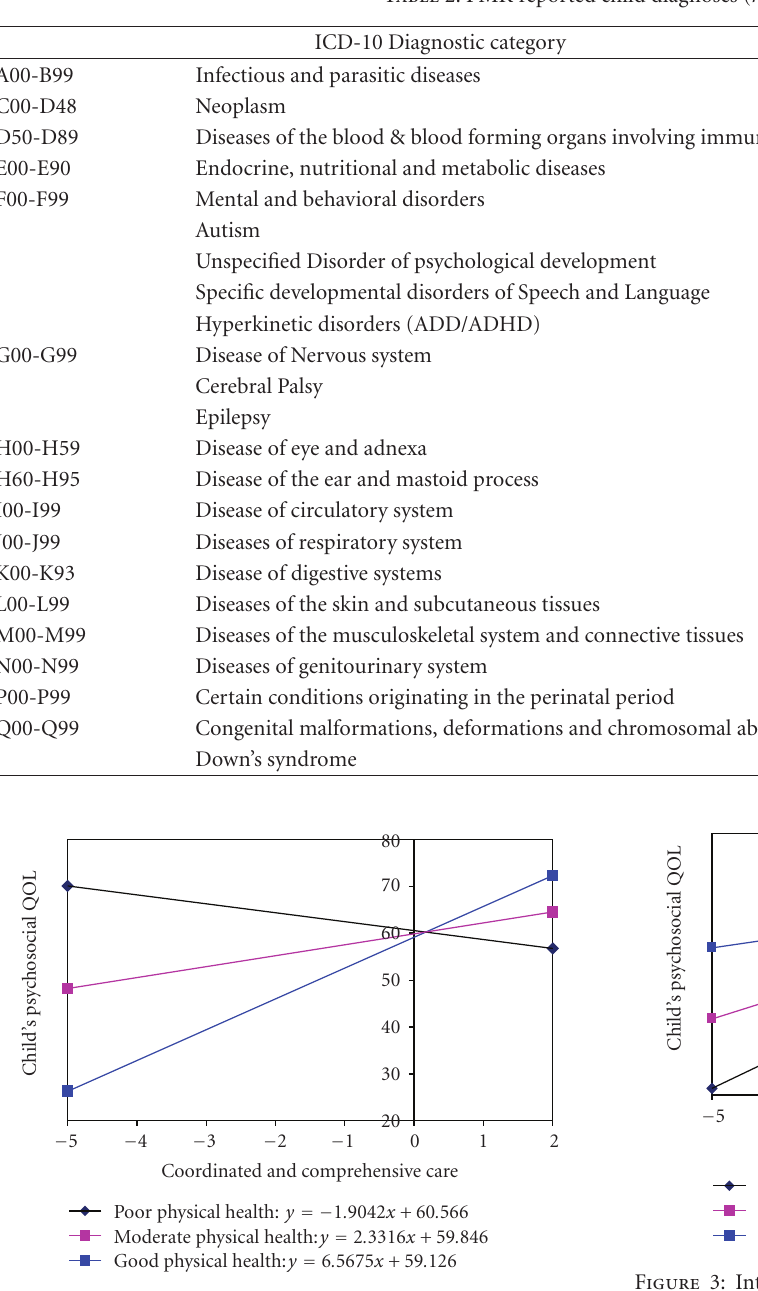
Figure 2: Interaction between Coordinated and Comprehensive Care and PMK Physical Health.